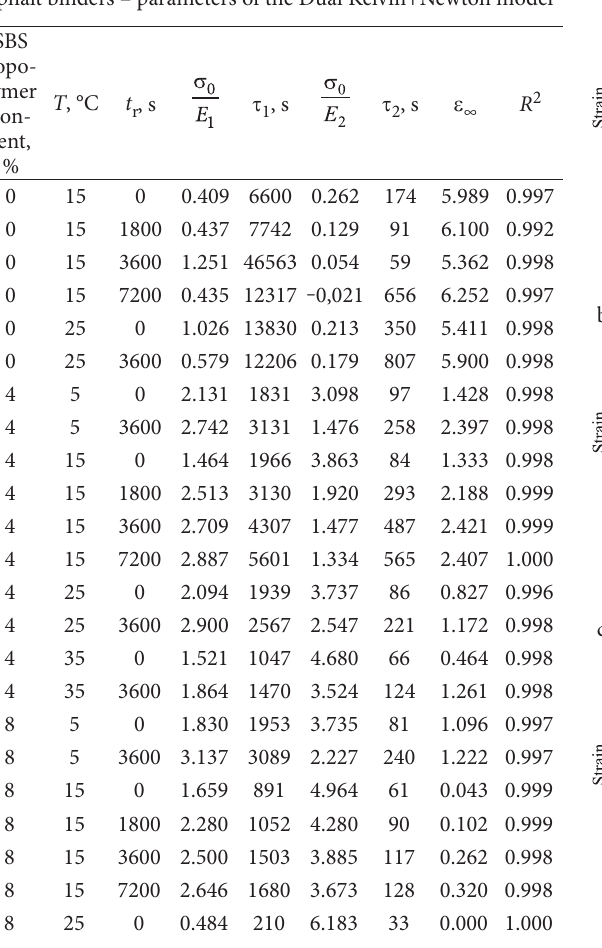
Fig. 5. Inverse creep curves of asphalt binders tested at: a – 5 °C; b – 25 °C; c – 35 °C; the Dual